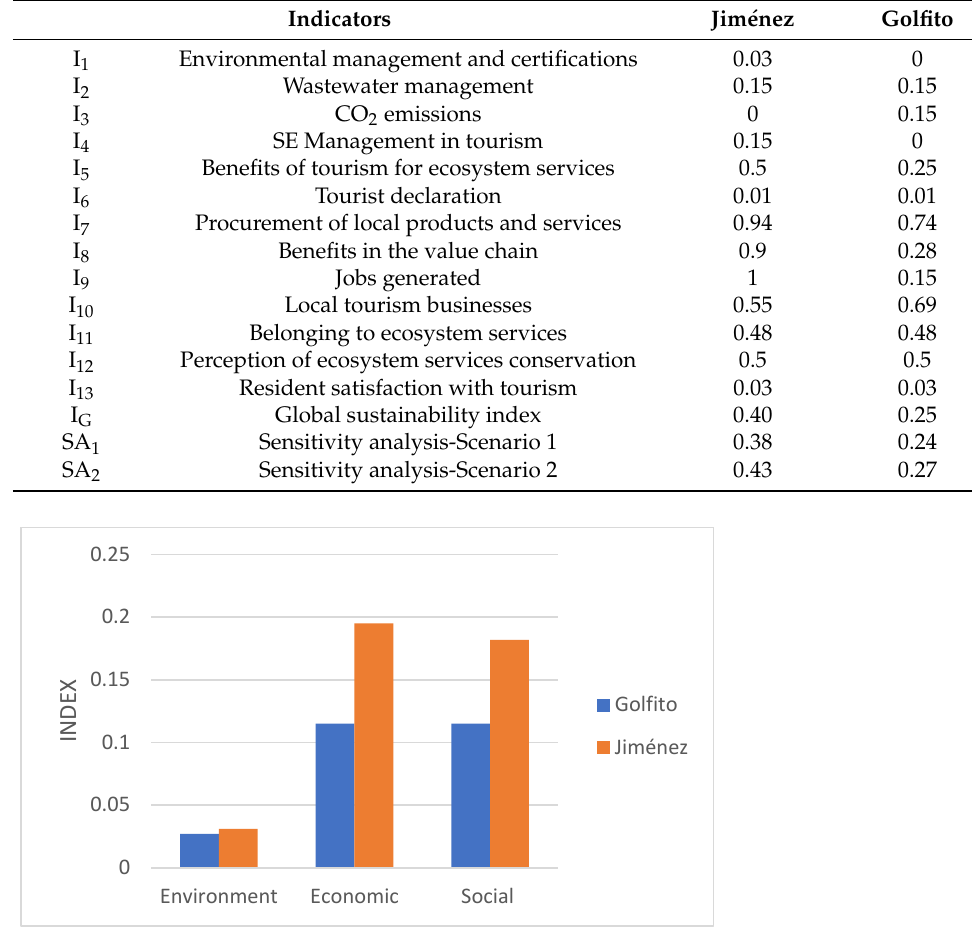
Figure 4. Sustainability values for both alternatives at the requirements level.